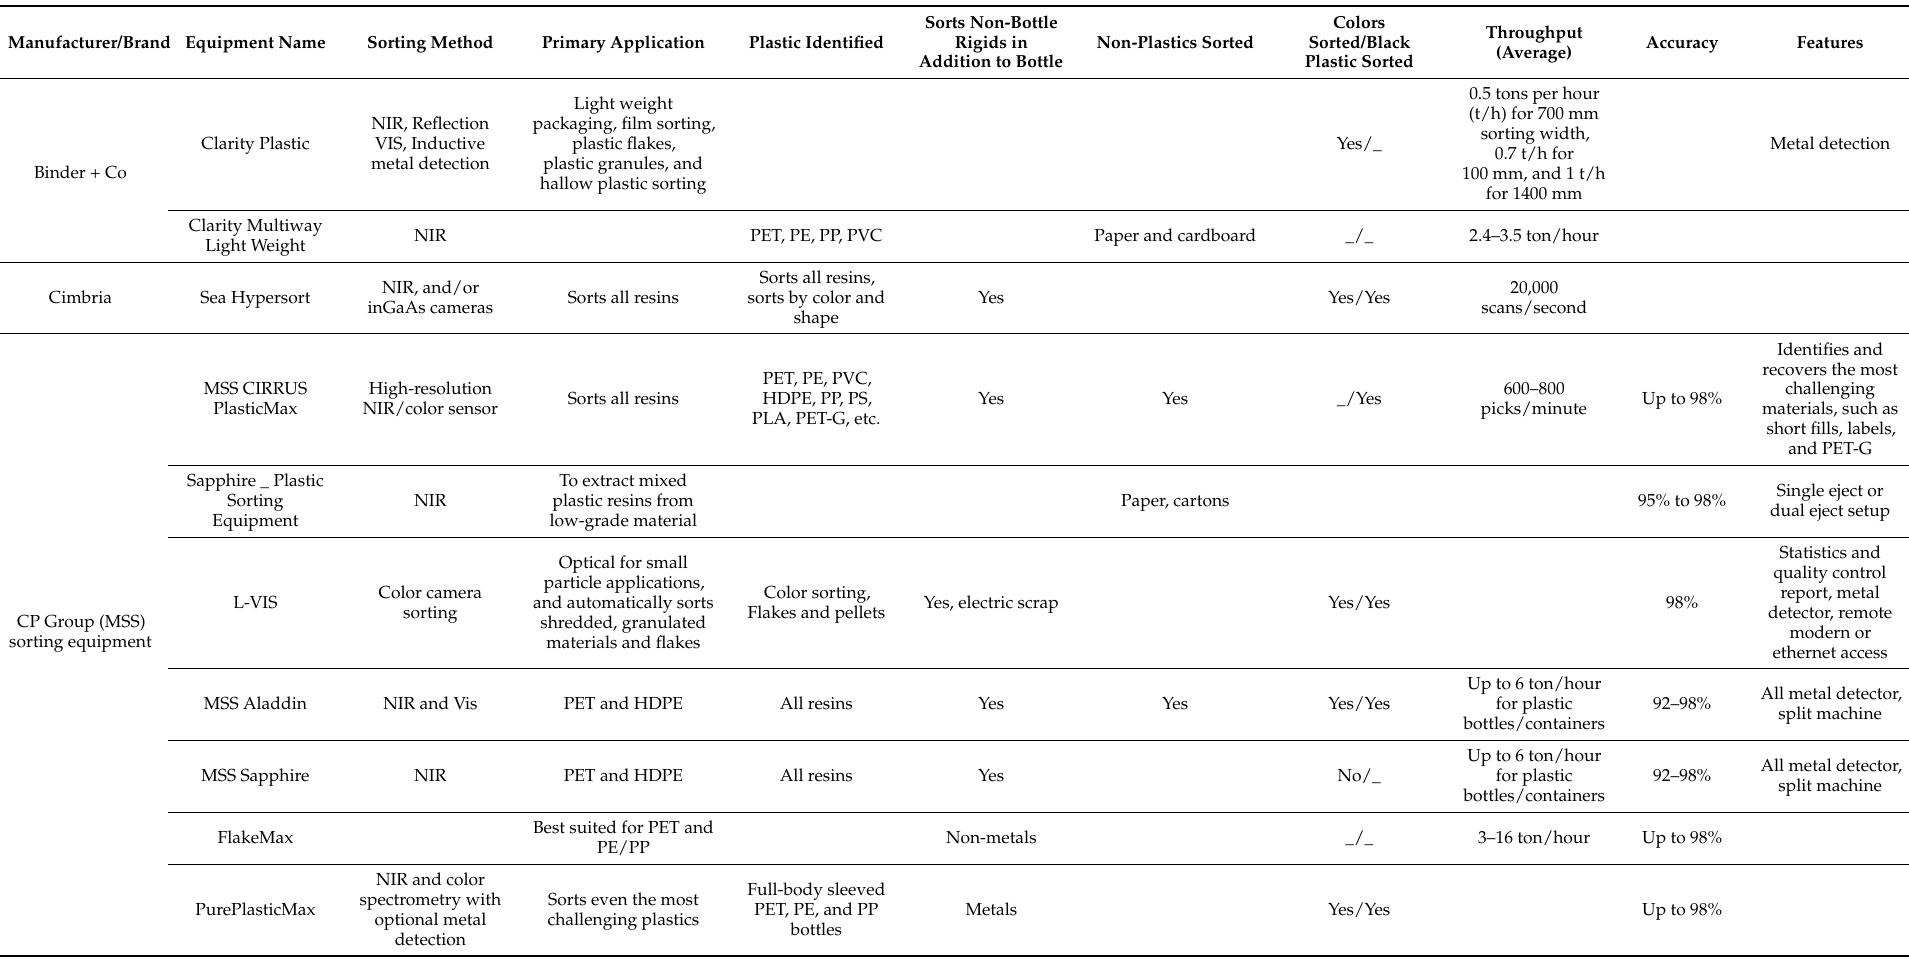
Table 3. Inventory of commercially available sorters for whole (i.e., bottle)